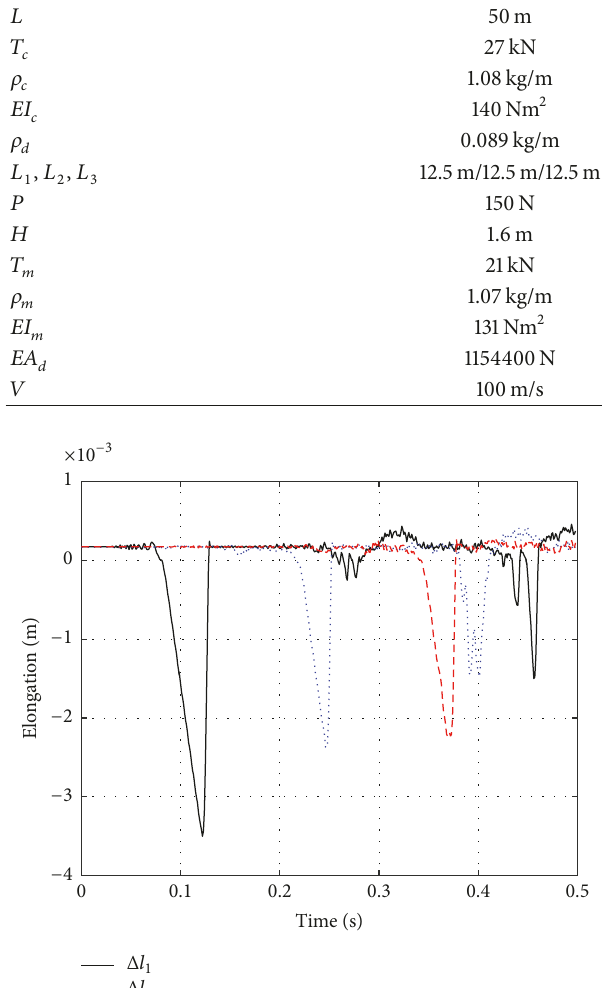
Table 2: Parameters of the catenary subjected to a moving force.